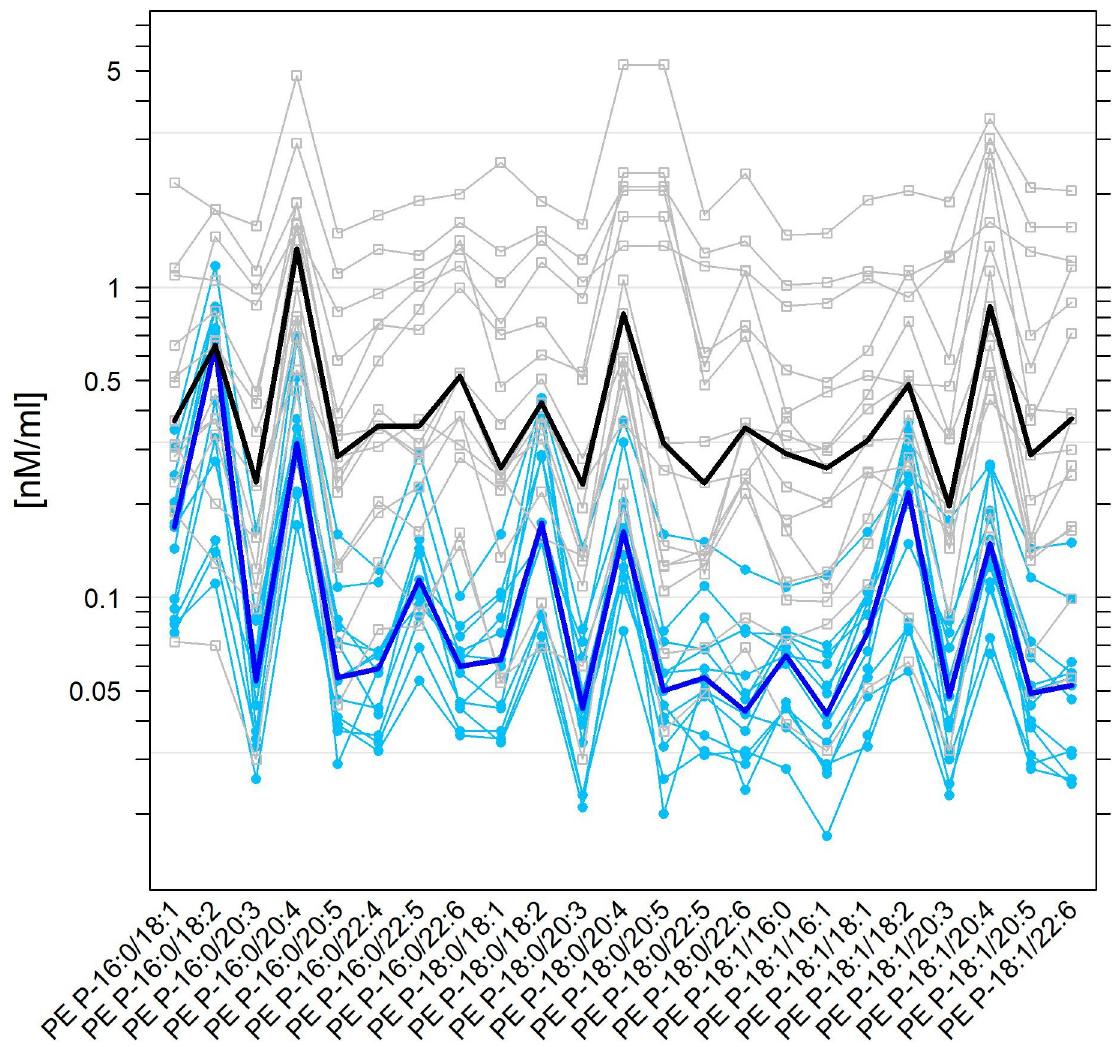
Fig 5. Superposed parallel plots for normal human and equine SF levels of PE P-16 and PE P-18 species. For further details, see the caption of Fig 2, which is fully analogous, but here for PE-P-16 and PE P18